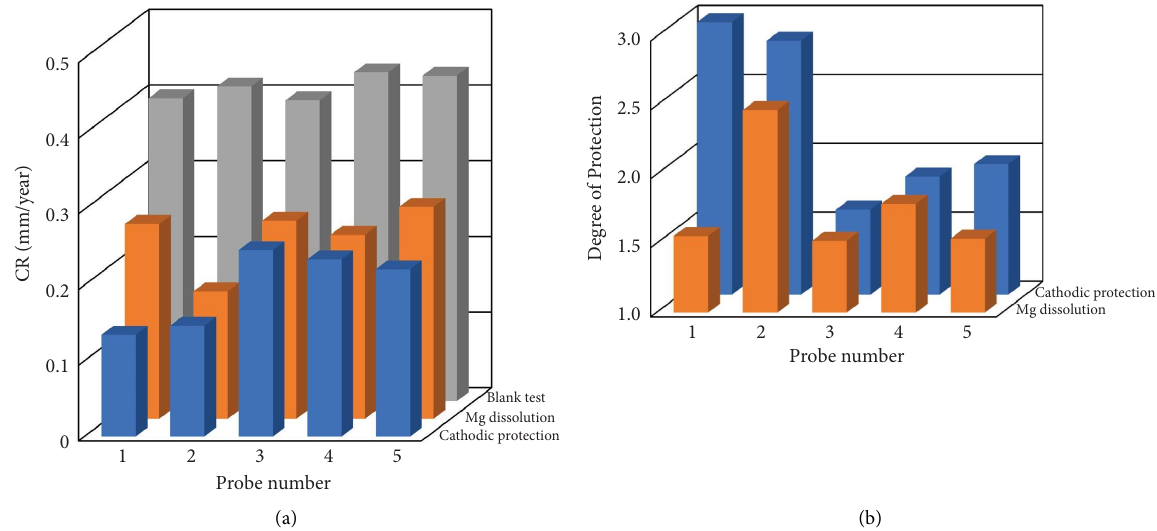
Figure 4: Weight loss corrosion rate and degree of protection with magnesium anode dissolution in tap water depending on the test